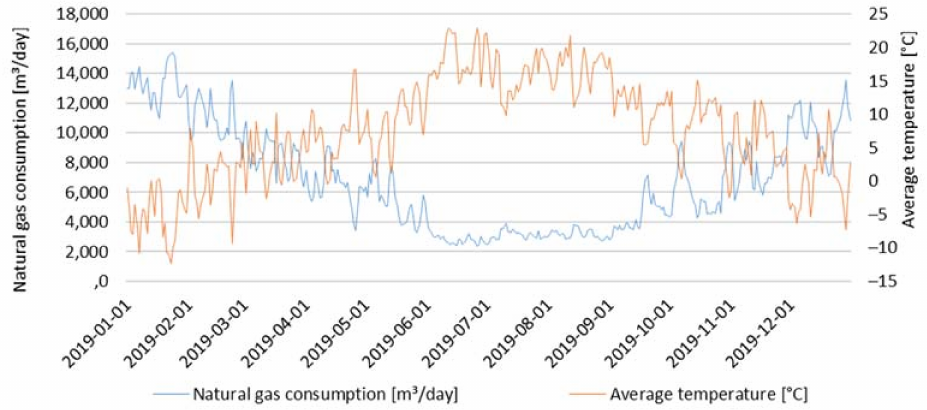
Figure 3. Natural gas consumption in 2019, depending on temperature [98]. Periods with the highest consumption are the winter months, such as January, February, and March as well as November and December. However, when considering gas consumption on a weekly basis, a slight drop can be observed on weekends (Figures 4 and 5).